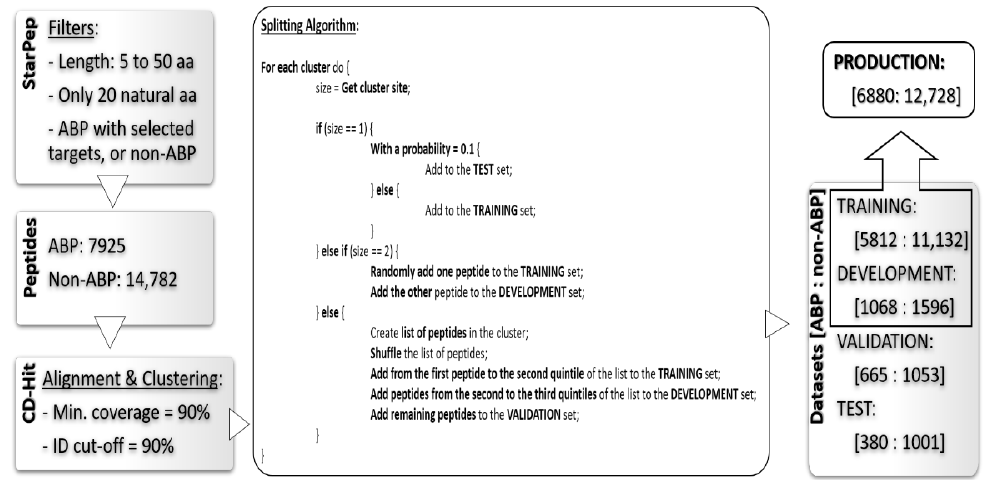
Figure 1. Workflow for the preparation of the datasets. The peptides extracted from StarPep were clustered with CD-Hit and subsequently distributed among the four sets used for training and testing the predictor. The final panel of the pipeline contains information about the number of peptides in every subset as well as their classification according to StarPep.